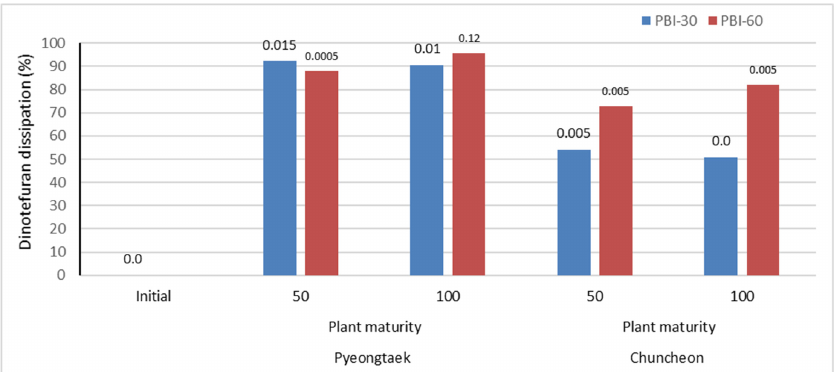
Figure 2. Dinotefuran dissipation (%) in celery soil of Pyeontaek and Chuncheon fields. Figure legend: values above the columns—standard error; PBI-30—30-day plant back intervals; PBI-60—60-day plant back intervals. Sample size: 4